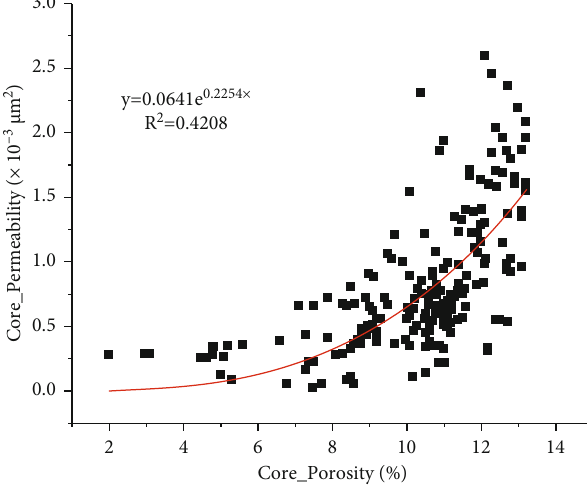
Figure 2: The relationship between core porosity and core